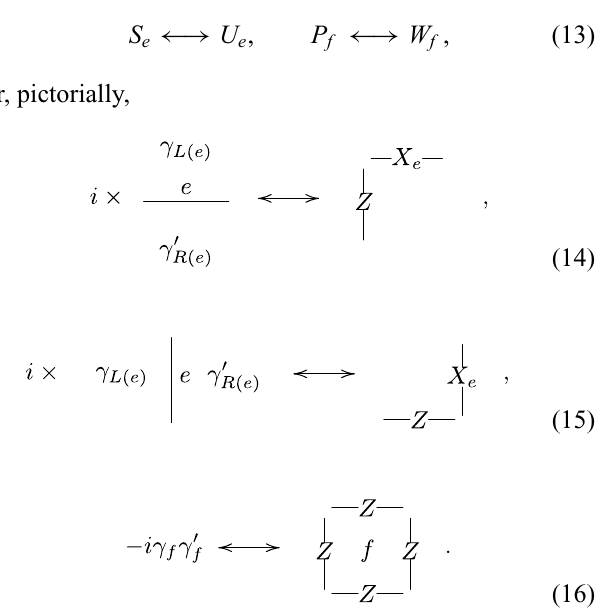
≡ − i ( c − c † ) for and γ (cid:7) f f f f